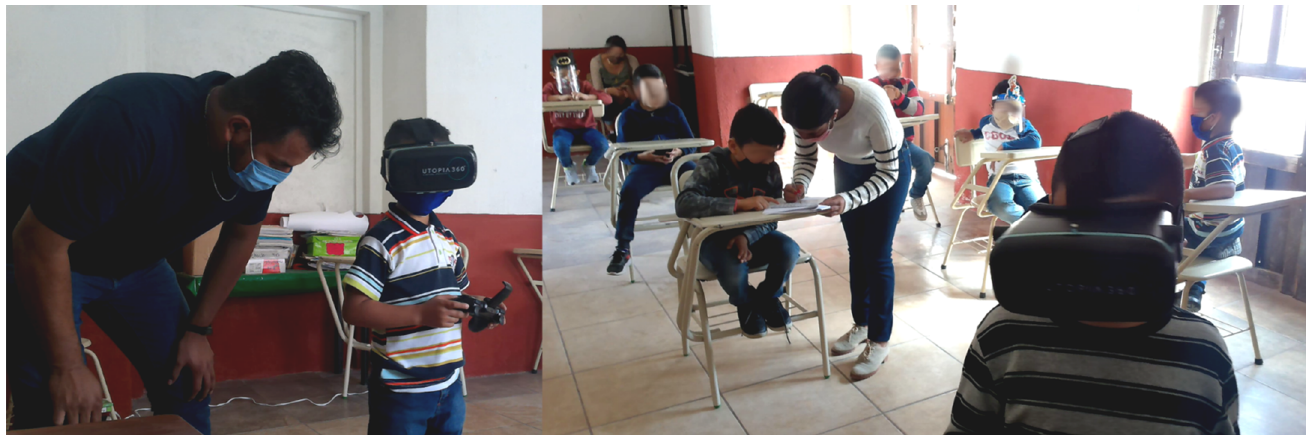
Figure A6. Use of virtual environment Attention-VR to support learning activities.